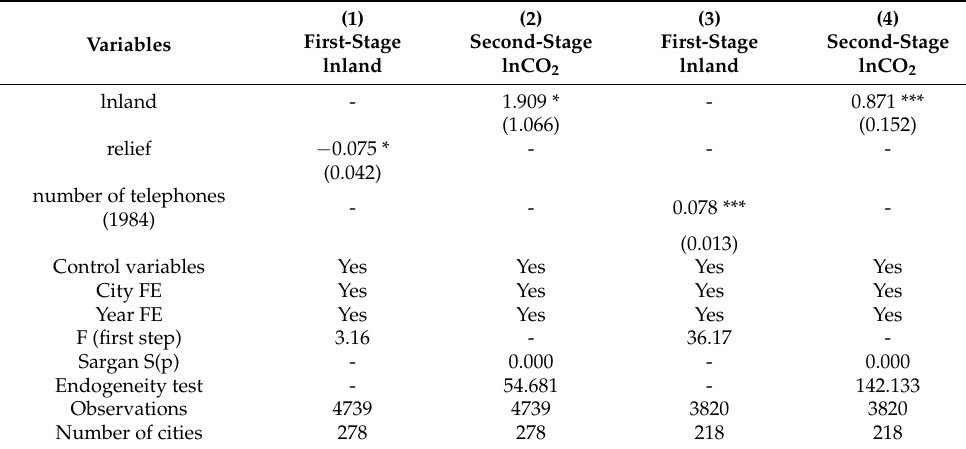
Table 3. The results of instrumental variable